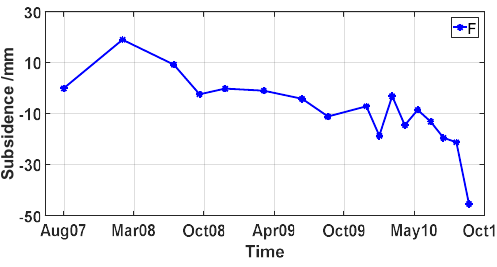
Figure 11. Surface subsidence time series with respect to PS point labeled as F in Figure